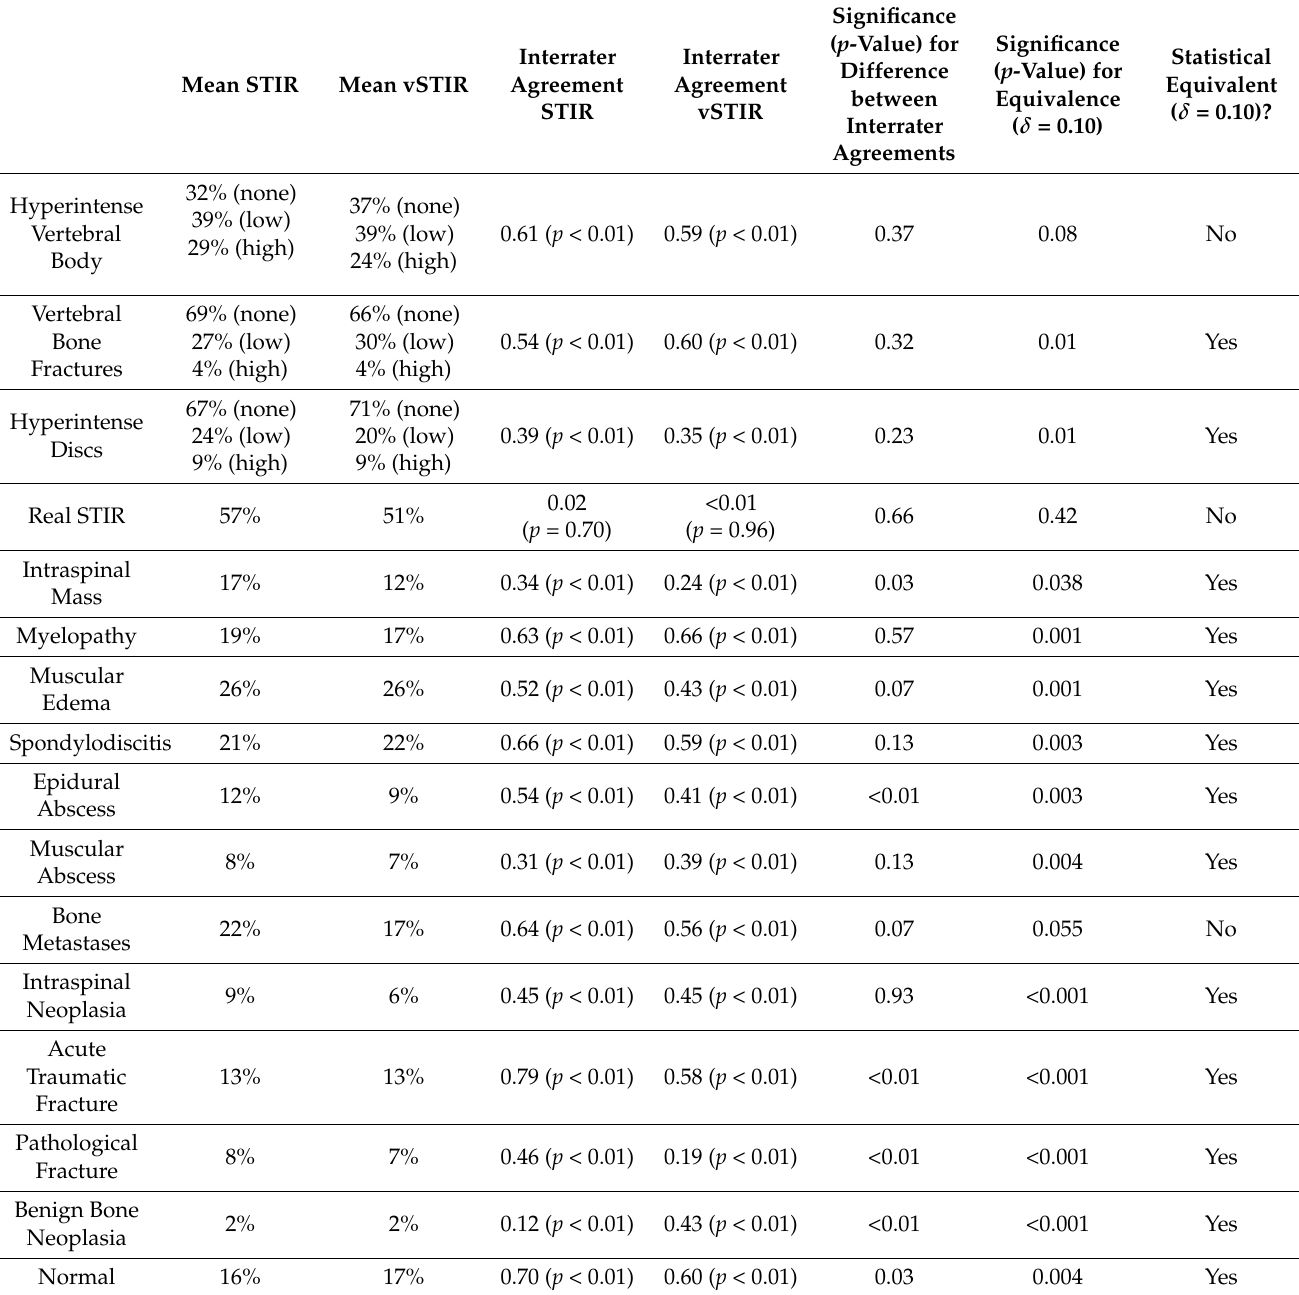
Table 5. Results of all equivalence